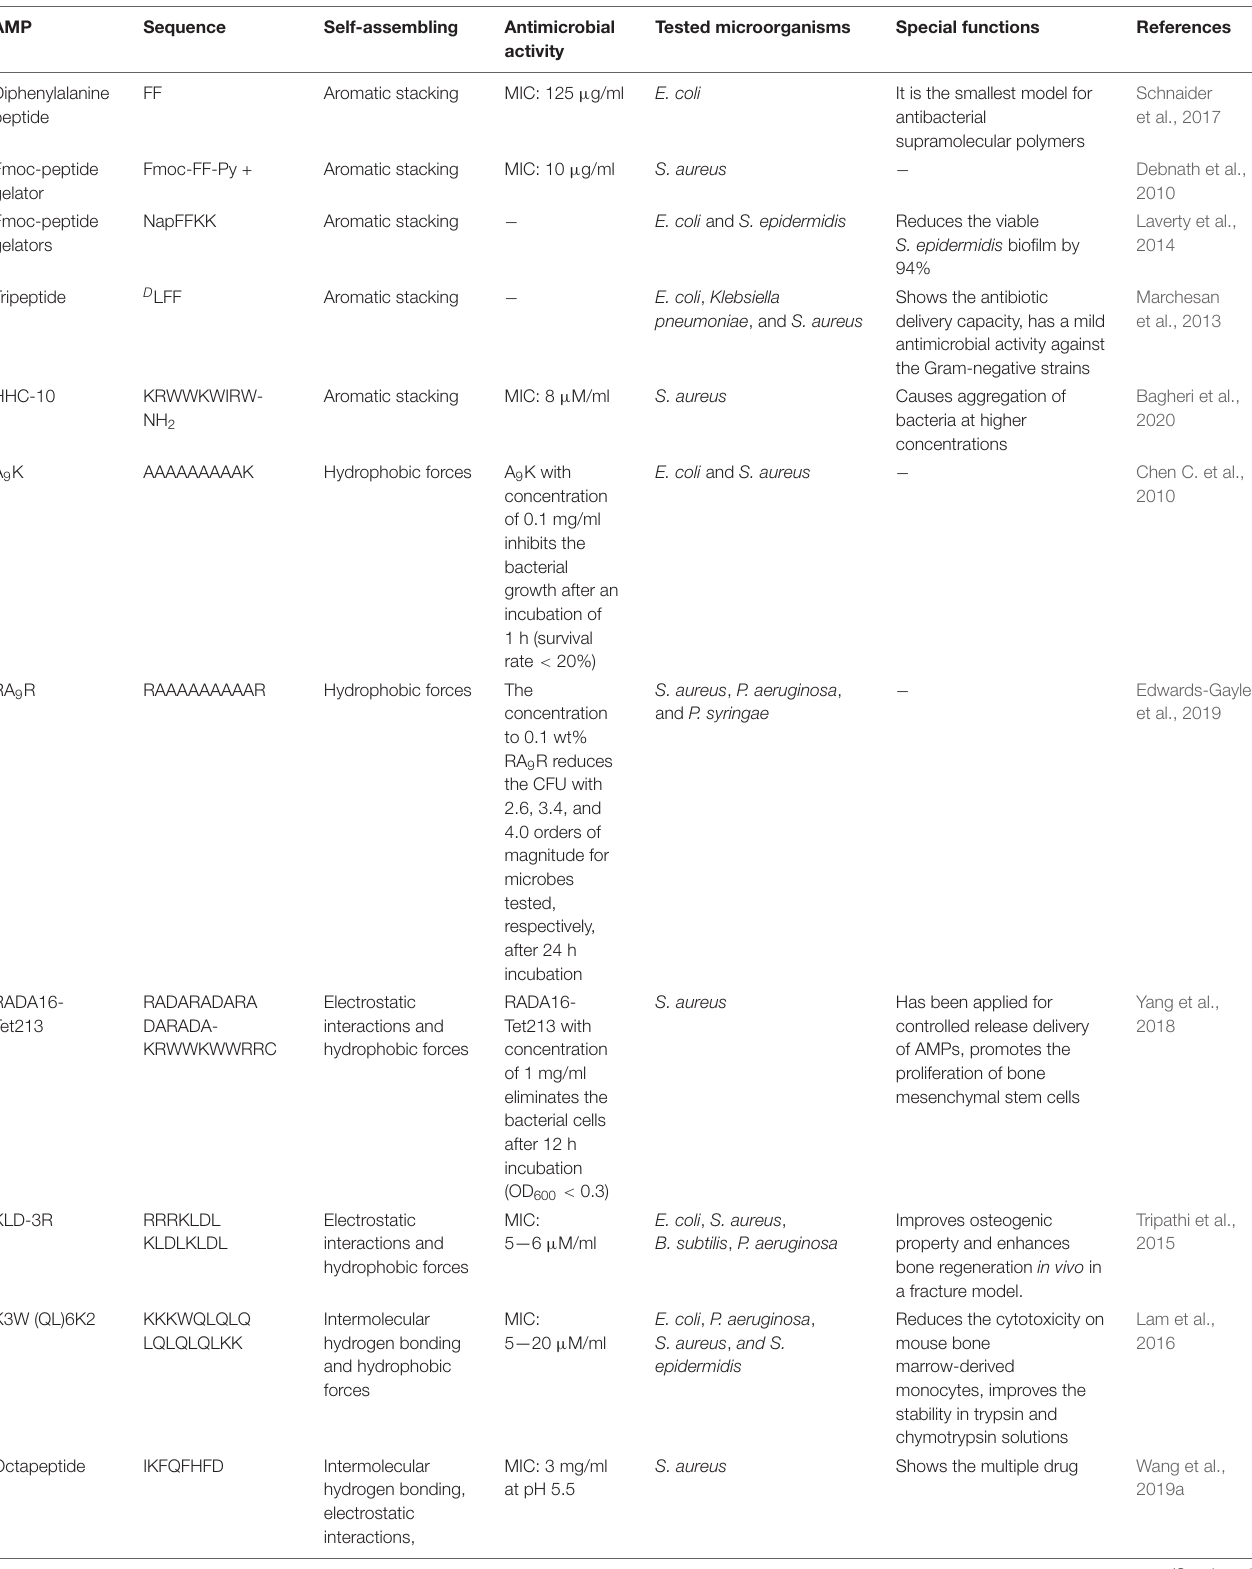
TABLE 3 | Most representative examples of self-assembled